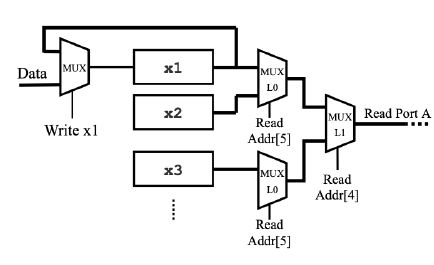
Figure 2: Register file [GHP +